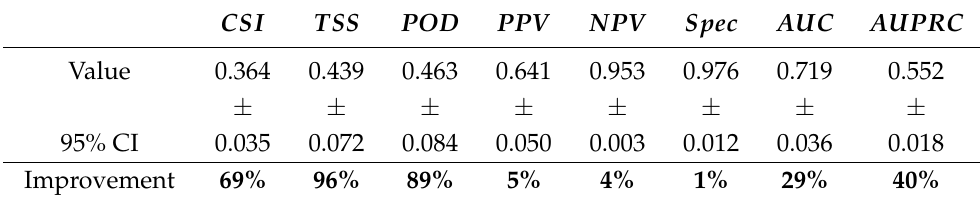
Improvement 69% 96% 89% 5% 4% 1%